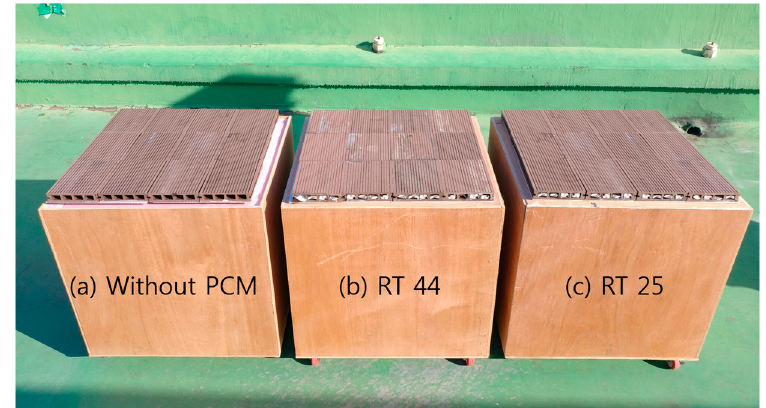
Figure 5. Small-scale models with as-manufactured WPC. ( a ) Without PCM; ( b ) Containing RT 44 in the hollows; and ( c ) With RT 25 in the hollows.